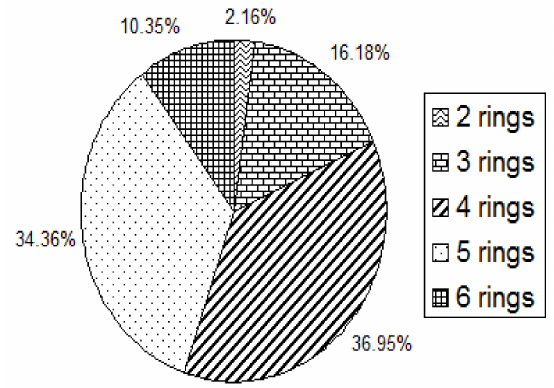
Figure 3. Pie chart diagram for the ring wise composition of different PAHs in the sediment samples of the study area.